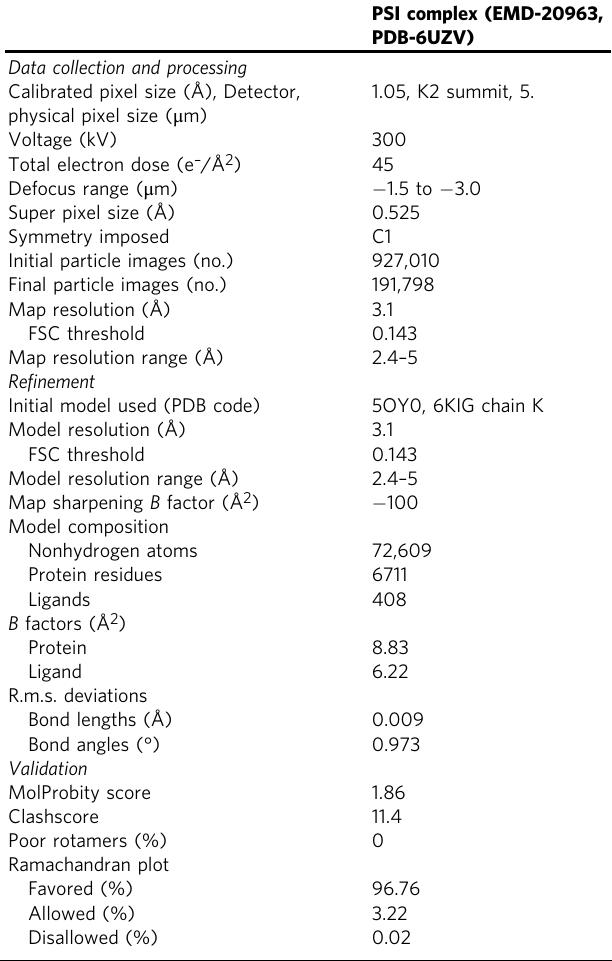
Table 2 Cryo-EM data collection, re fi nement, and validation statistics.